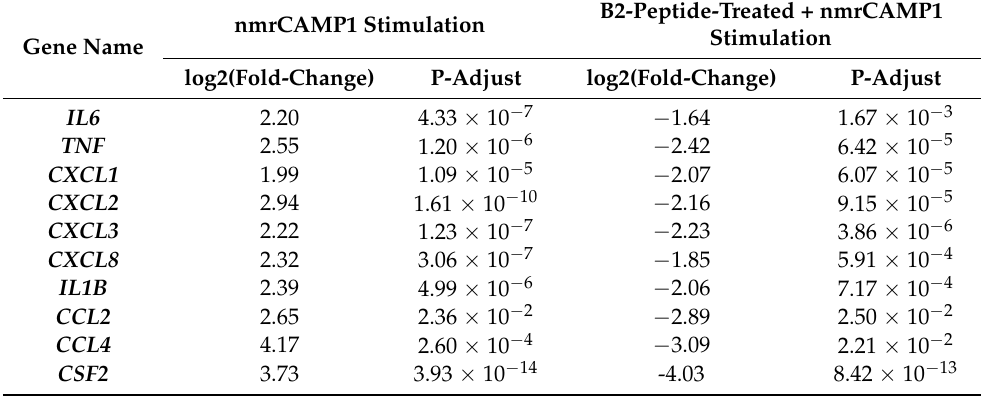
Table 2. The 10 genes displaying the highest levels of differential expression for the 12 common KEGG pathways a